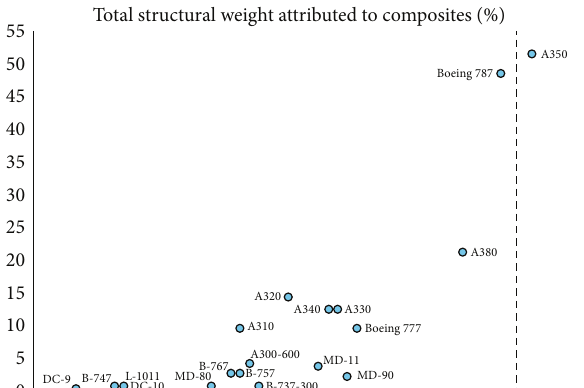
Figure 1: The percentage of composite materials used in an aircraft